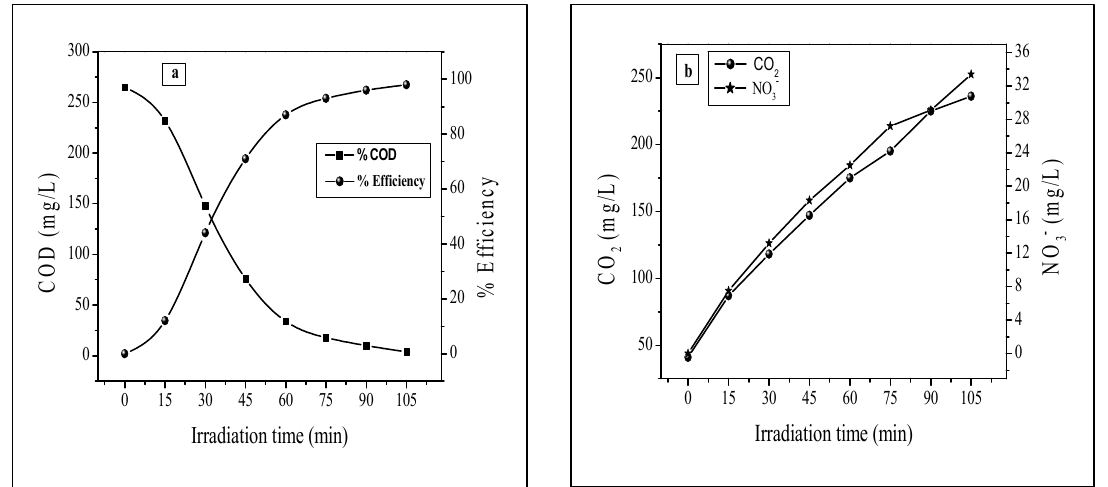
Figure 6. ( a ) measurement of COD removal ( b ) Measurement of CO 2 and nitrate removal.